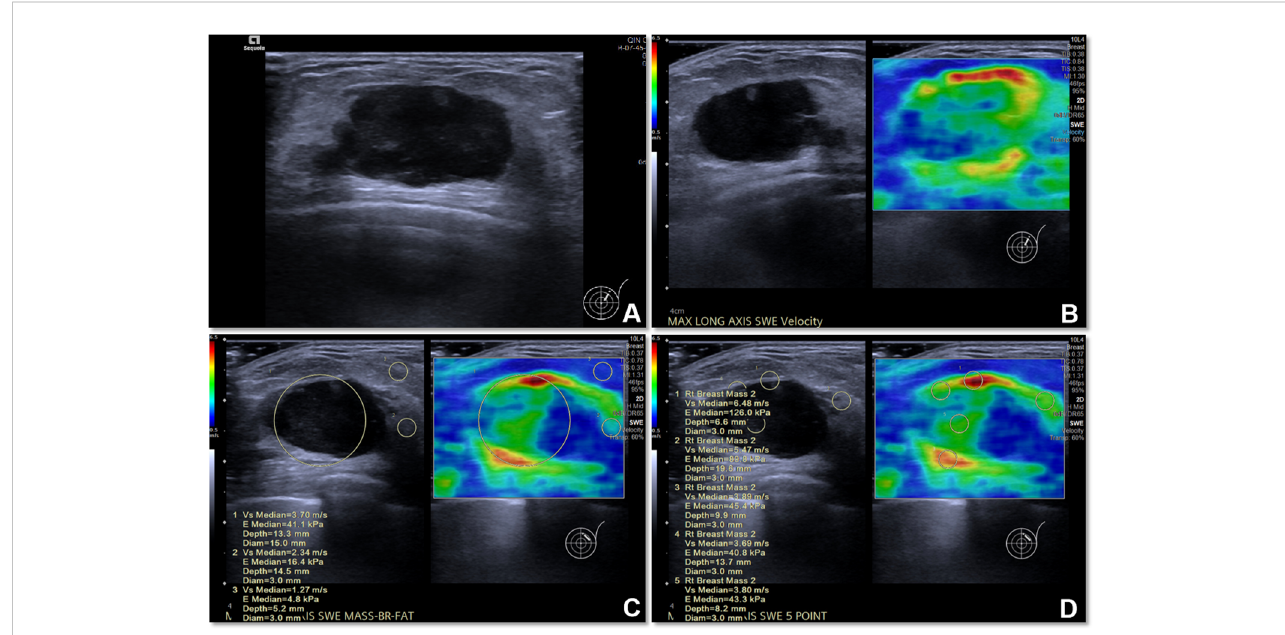
FIGURE 2 The US image and quantitative SWE parameters of metaplastic carcinoma (sarcomatoid carcinoma) in a 77-year-old woman. (A) US image of the lesion. (B) SWE image of the lesion. (C) The SWV1 value of the lesion was 3.70 m/s, while that of the normal mammary gland was 2.34 m/s and that of adipose tissue was 1.27 m/s. (D) The SWV5 value of the lesion and peritumoral region was 4.66